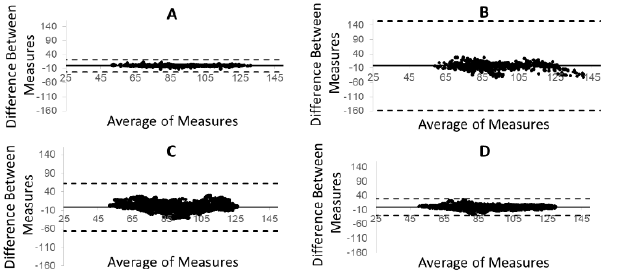
Figure 5. Bland – Altman plots of heart rate (bpm) during walking activity for the ( A ) Apple Watch series 4, ( B ) Garmin Forerunner 735XT, ( C ) Jabra Elite earbuds, and ( D ) Scosche Rhythm 24 devices compared to the Polar H7. Dashed lines represent 95% limits of agreement.